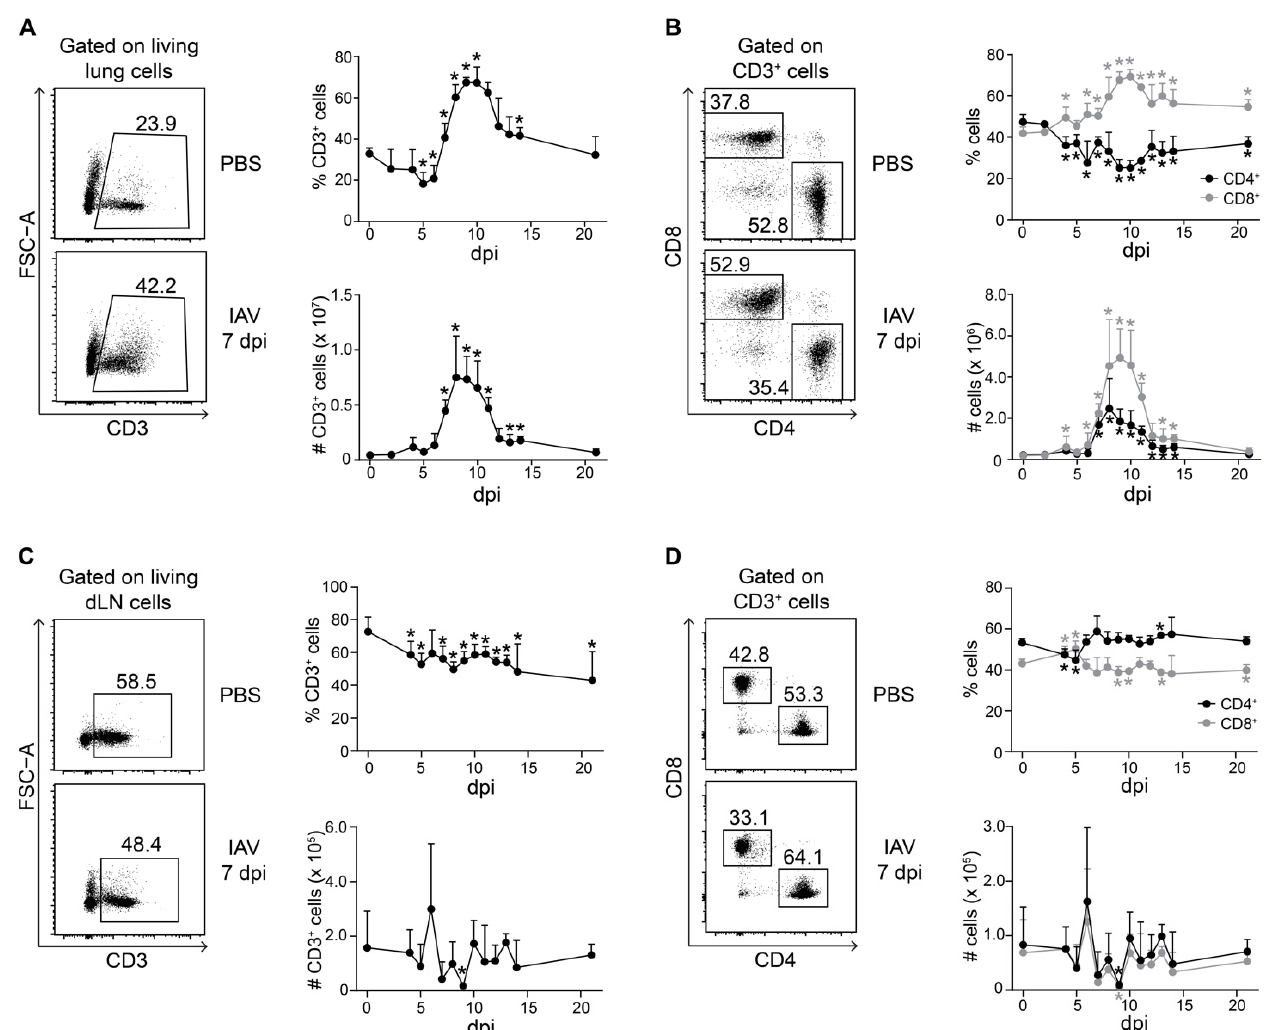
Figure 1. Kinetics of T cell accumulation during IAV infection. Foxp3 hCD2 × Rag1 GFP reporter mice were infected with IAV and analyzed at indicated dpi. Lungs and dLNs were collected and prepared, and single-cell suspensions were restimulated and subsequently analyzed by flow cytometry. ( A ) Representative dot plots depict frequency of CD3 + T cells in lungs of PBS-treated and IAV-infected mice (7 dpi), gated on living lung lymphocytes. The graphs summarize frequencies (top) and absolute numbers (bottom) of CD3 + T cells; ( B ) Representative dot plots depict frequency of CD4 + and CD8 + T cells in lungs of PBS-treated and IAV-infected mice (7 dpi), gated on CD3 + T cells. The graphs summarize frequencies (top) and absolute numbers (bottom) of CD4 + (black filled circles) and CD8 + T cells (gray filled circles); ( C ) Representative dot plots depict frequency of CD3+ T cells in dLNs of PBS-treated and IAV-infected mice (7 dpi), gated on living dLN lymphocytes. The graphs summarize frequencies (top) and absolute numbers (bottom) of CD3 + T cells; ( D ) Representative dot plots depict frequency of CD4 + and CD8 + T cells in dLNs of PBS-treated and IAV-infected mice (7 dpi), gated on CD3 + T cells. The graphs summarize frequencies (top) and absolute numbers (bottom) of CD4 + (black filled circles) and CD8 + T cells (gray filled circles). Data were pooled from two to three independent experiments, which included 4–10 mice per group, and presented as mean + SD. Mann–Whitney test was used to calculate statistical significance by comparing values from untreated animals (for lung samples) or PBS-treated animals (for dLN samples) (0 dpi) with values from IAV-infected mice (2 to 21 dpi). Significant changes are indicated by an